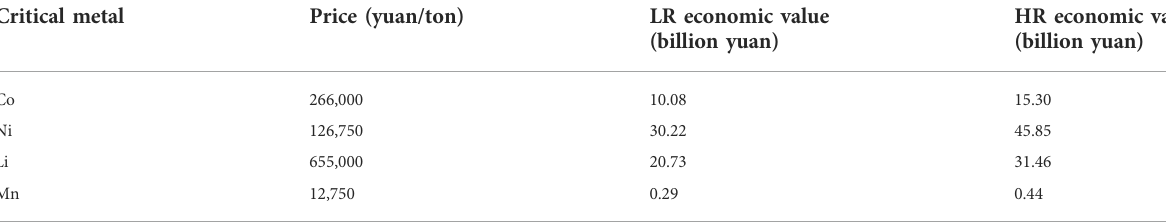
TABLE 8 The economic value of critical metals recycling in 2030 in China. Critical